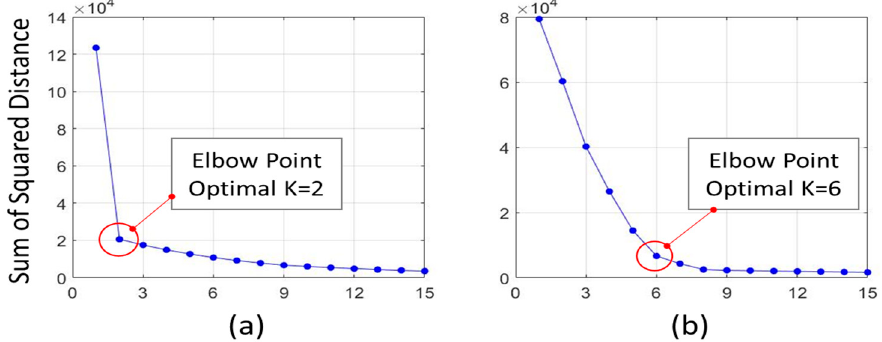
Figure 4. Optimal values of k -means clustering: ( a ) First clustering for all gaits and ( b ) second clustering for only abnormal gaits (excluding normal gaits).